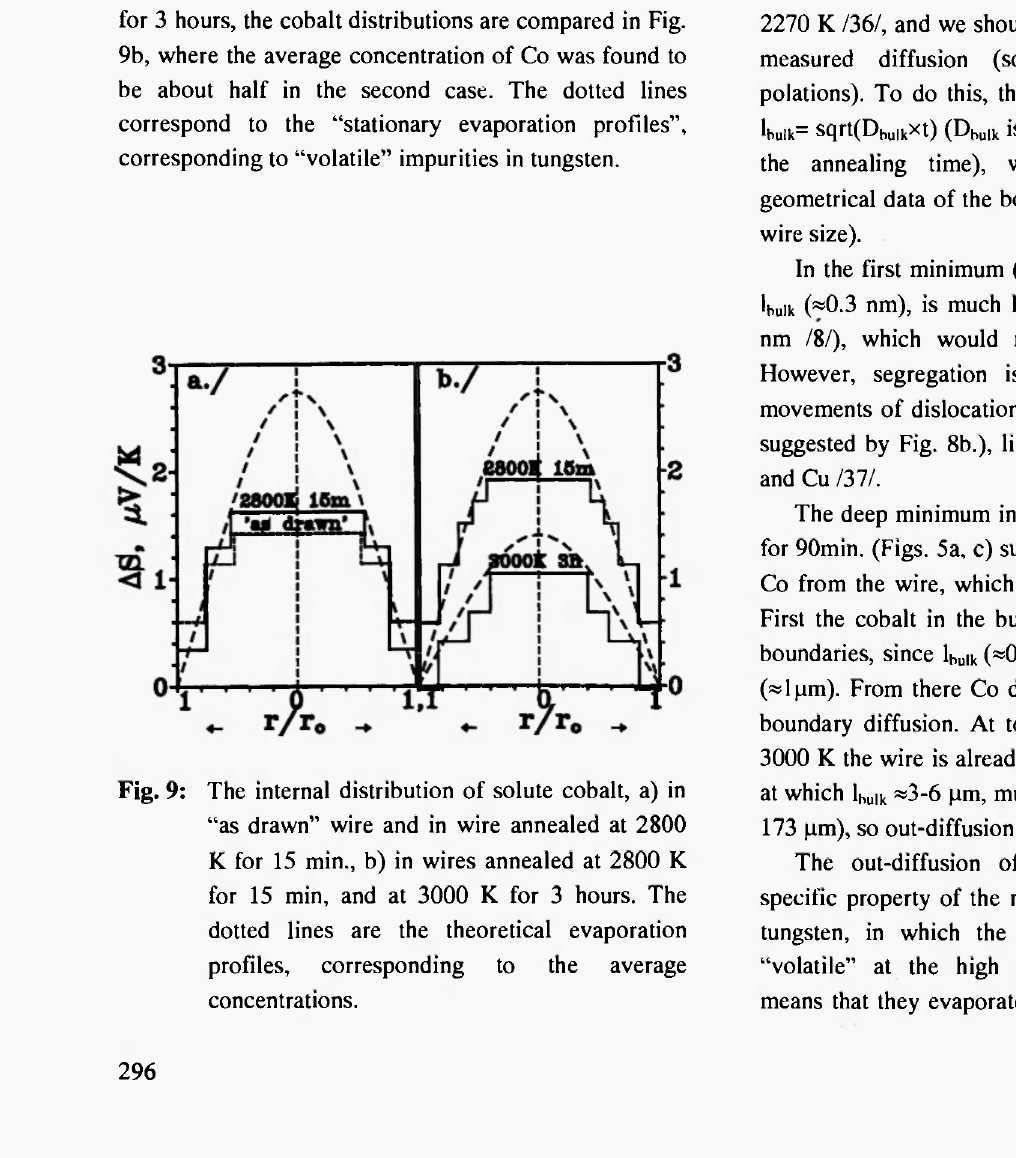
Fig. 9: The internal distribution of solute cobalt, a) in "as drawn" wire and in wire annealed at 2800 Κ for 15 min., b) in wires annealed at 2800 Κ for 15 min, and at 3000 Κ for 3 hours. The dotted lines are the theoretical evaporation profiles, corresponding to the average